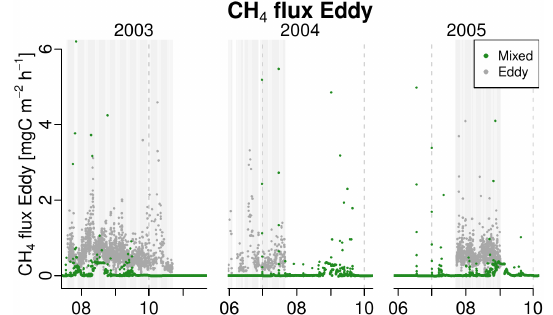
Figure 7. Modelled methane flux out of soil in a mixed approach of 65% rim plus 35% centre compared to eddy covariance mea- surements. Light grey background indicates measurement data cov- erage. X axes indicate the first day of the respective month of the year. Dashed lines indicate 1 July and 1 October of the respective year. Please note the cutouts in between the different years. Be- cause of the wide spread of high modelled values, to as high as 30.4mg Cm − 2 h − 1 , a portion of 0.0507% modelled values was cut to provide a reasonable picture. The minimum of the modelled val- ues is − 0 . 0235mg Cm − 2 h − 1